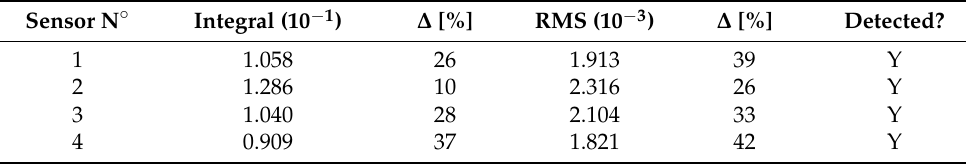
Table 13. Integral and RMS of frequency spectrum, slab with void below